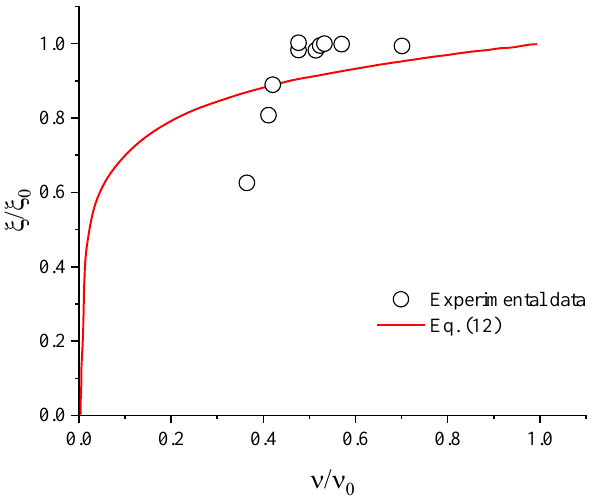
Figure 4. Normalized gel fraction versus normalized crosslink density for GTR processed in a ther- mokinetic mixer. Symbols are experimental data, and the solid line in red is the fit of Equation (12).